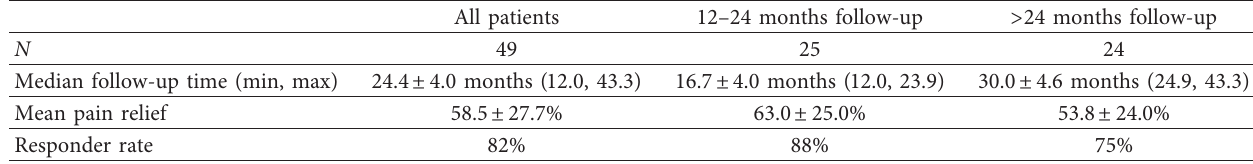
Table 2: Pain relief and responder rate in patients with follow-up > 12 months.